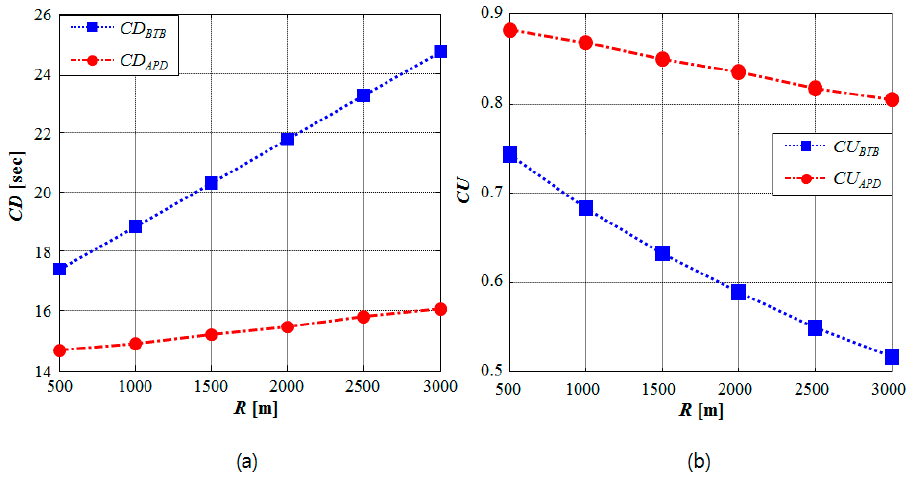
Figure 9. ( a ) The CD and ( b ) the CU of the APD-TDMA and the BTB-TDMA versus the network range when 25 nodes move at the maximum speed of 5 m/s.